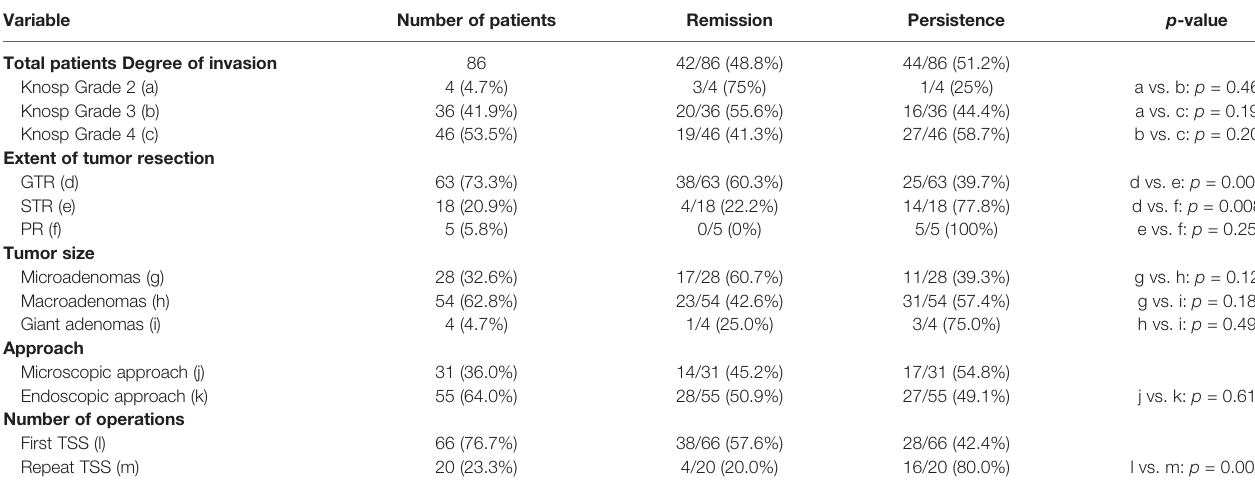
TABLE 3 | Rate of immediate remission and recurrence by subgroups based on different variables.